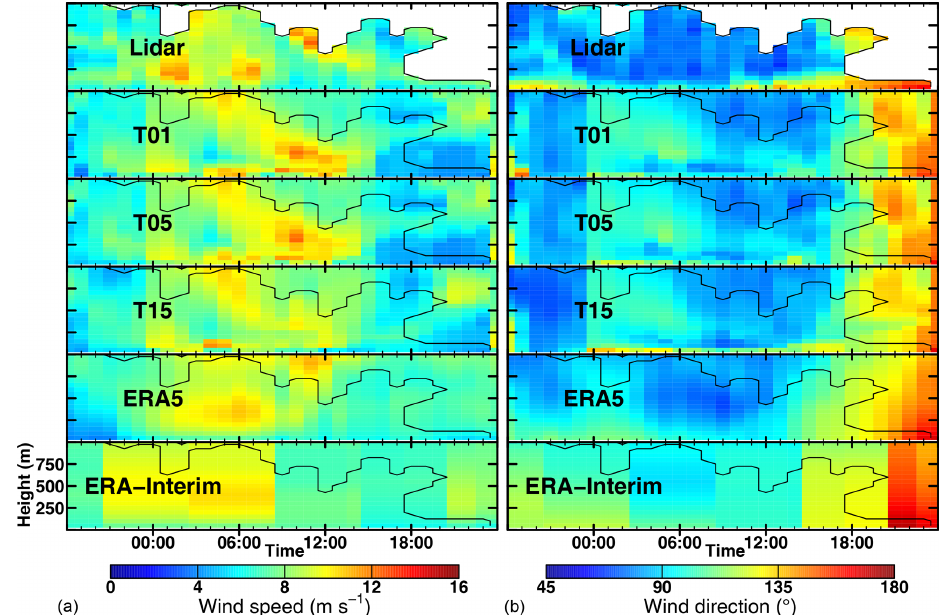
Figure 15. Time–height cross sections for (a) wind speed and (b) direction for 16 January 2016 18:00UTC to 17 January 2016